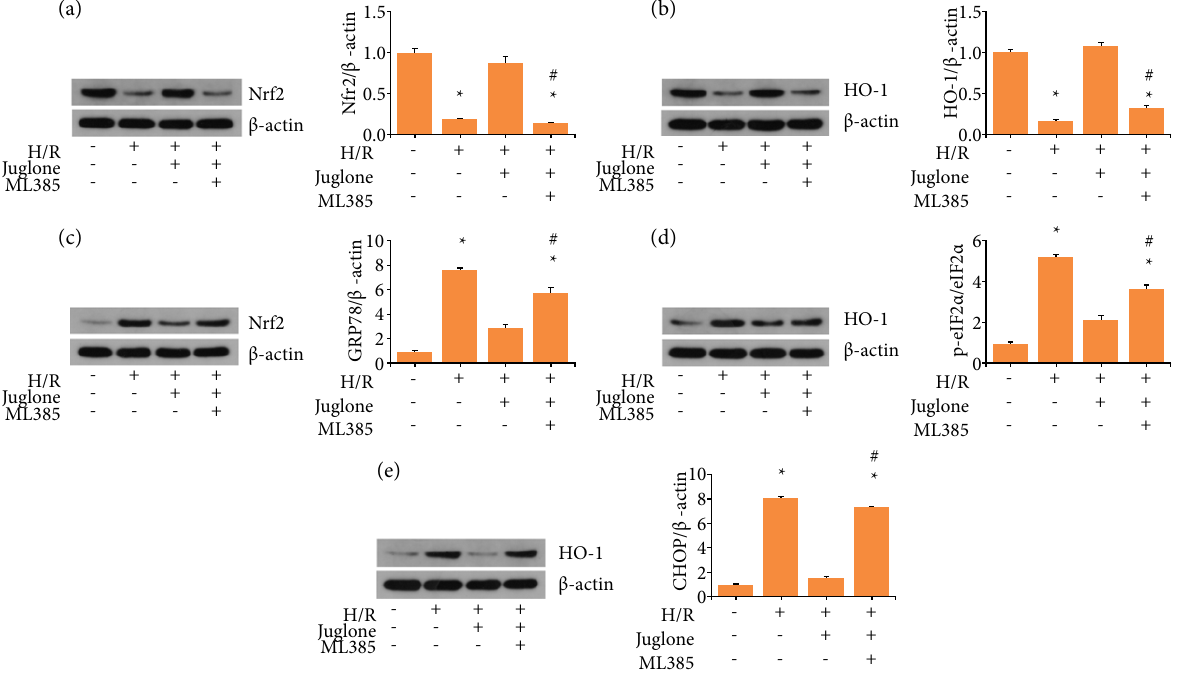
Figure 6 - Pin1 regulates endoplasmic reticulum stress induced by H/R through Nrf2/HO-1 pathway. HK-2 cells were treated with Pin1 inhibitor (10 μ mol∙L –1 ) for 1 h, followed by H/R, with or without pretreatment with Nrf2 inhibitor ML385 (5 μ mol∙L –1 ). (a, b) The expression of Nrf2/HO-1 pathway was detected by western blot and quantification was performed. (c–e) The expression of GRP78, p-eIF2 α , and CHOP were detected by western blot and quantification was performed relative to control group. Values were expressed as the mean ± SEM (n = 8). *P < 0.05, relative to control group; #P < 0.05, relative to Juglone